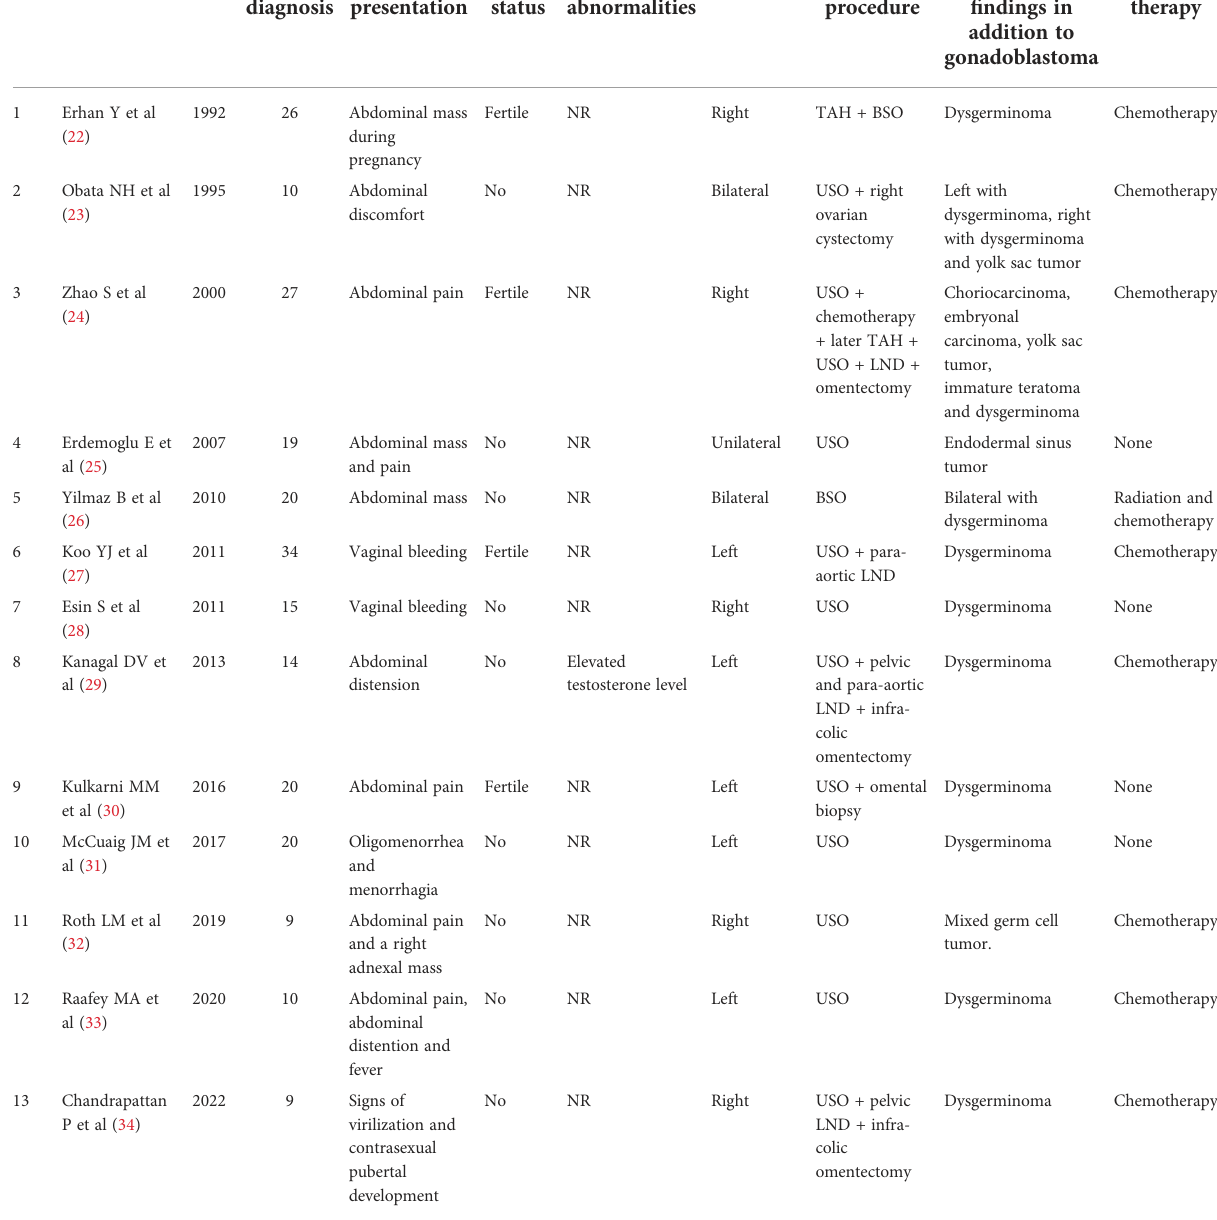
TABLE 2 Summary of published female cases of gonadoblastoma with normal 46, XX karyotype.